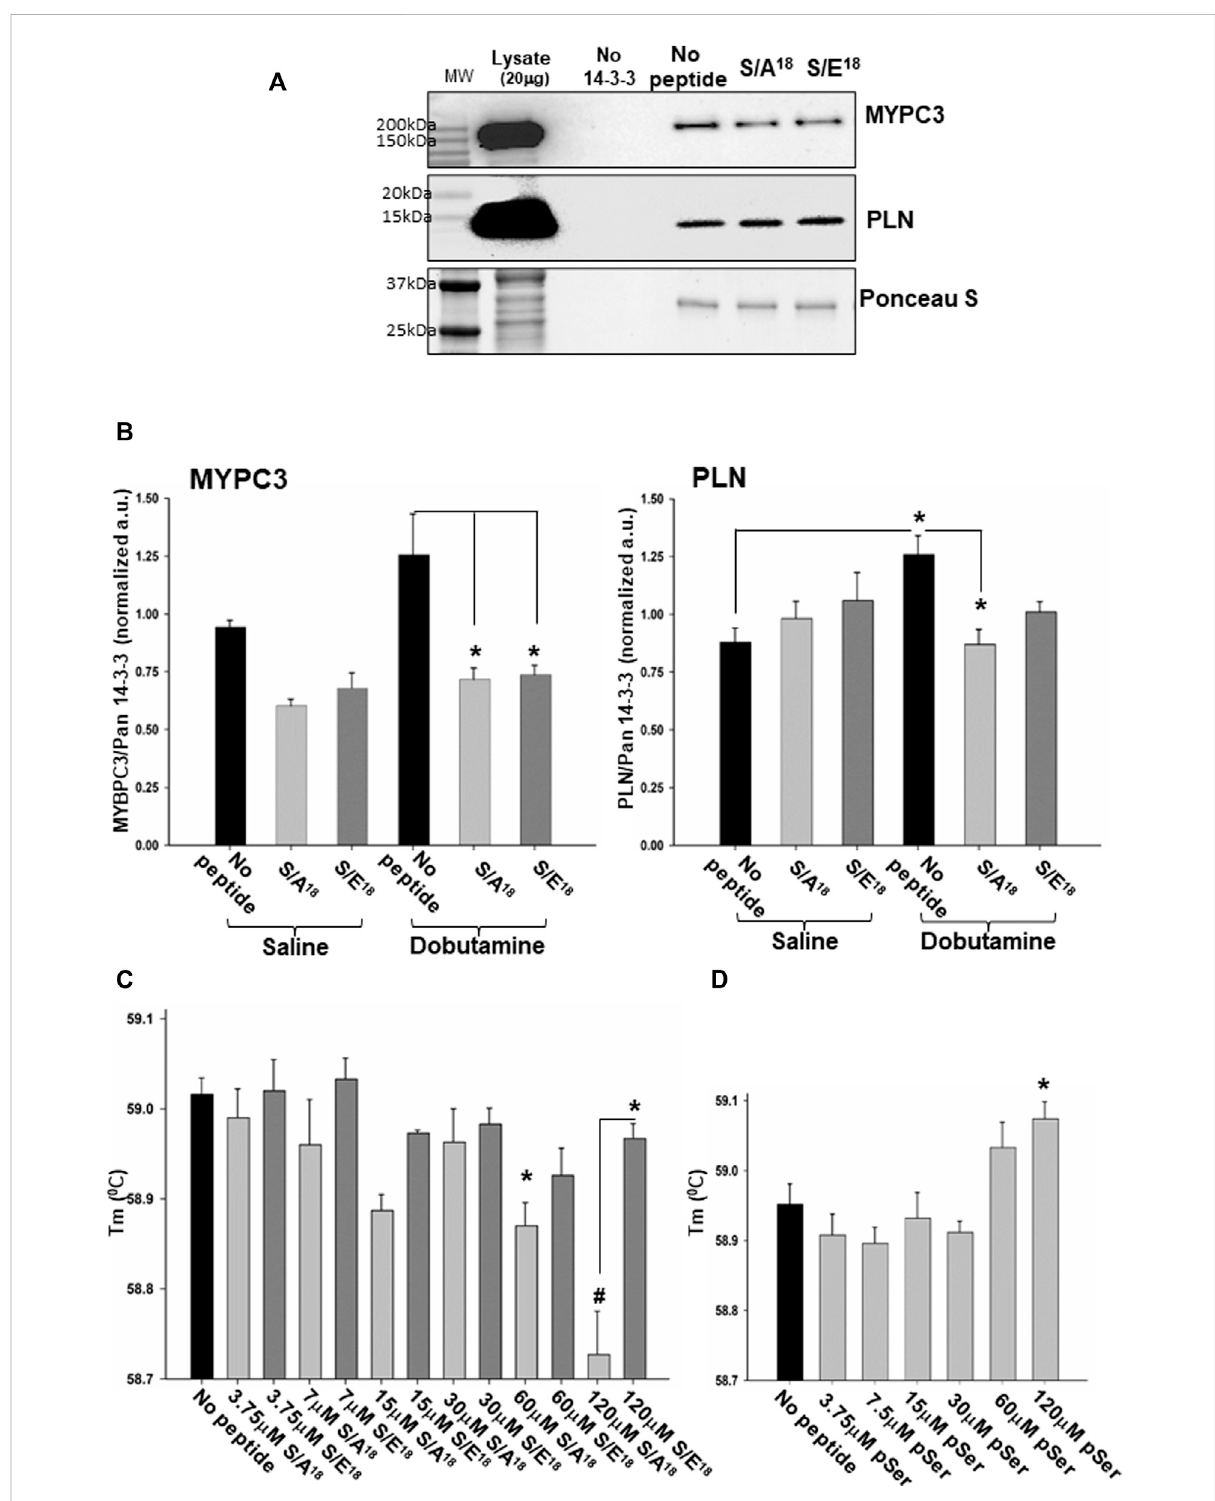
FIGURE 10 MGF E-domain peptide modulation of 14-3-3 γ interactions. (A) . Representative immunoblot of 14-3-3 γ capture of myosin binding protein C3andphospholambanwithS/A 18 andS/E 18 peptidesinheartlysatesofsalineinjectedmice(lysate20 μ g,peptides20 μ M). (B) .Quanti fi cationof14-3- 3 γ /MYPC3and14-3-3 γ /PLNinteractionsinheartlysatesofsalineanddobutamineinjectedmice(* p < 0.05 vsnopeptide, n =4). (C) .Thermalstability of recombinant 14-3-3 γ with varying concentrations of S/A 18 , S/E 18 peptides. (D) . Thermal stability of recombinant 14-3-3 γ with varying concentrations of pS 18 E-domain peptide (* p < 0.05 vs no peptide CTL or between peptides, # p < 0.01 vs no peptide, n = 3 independent